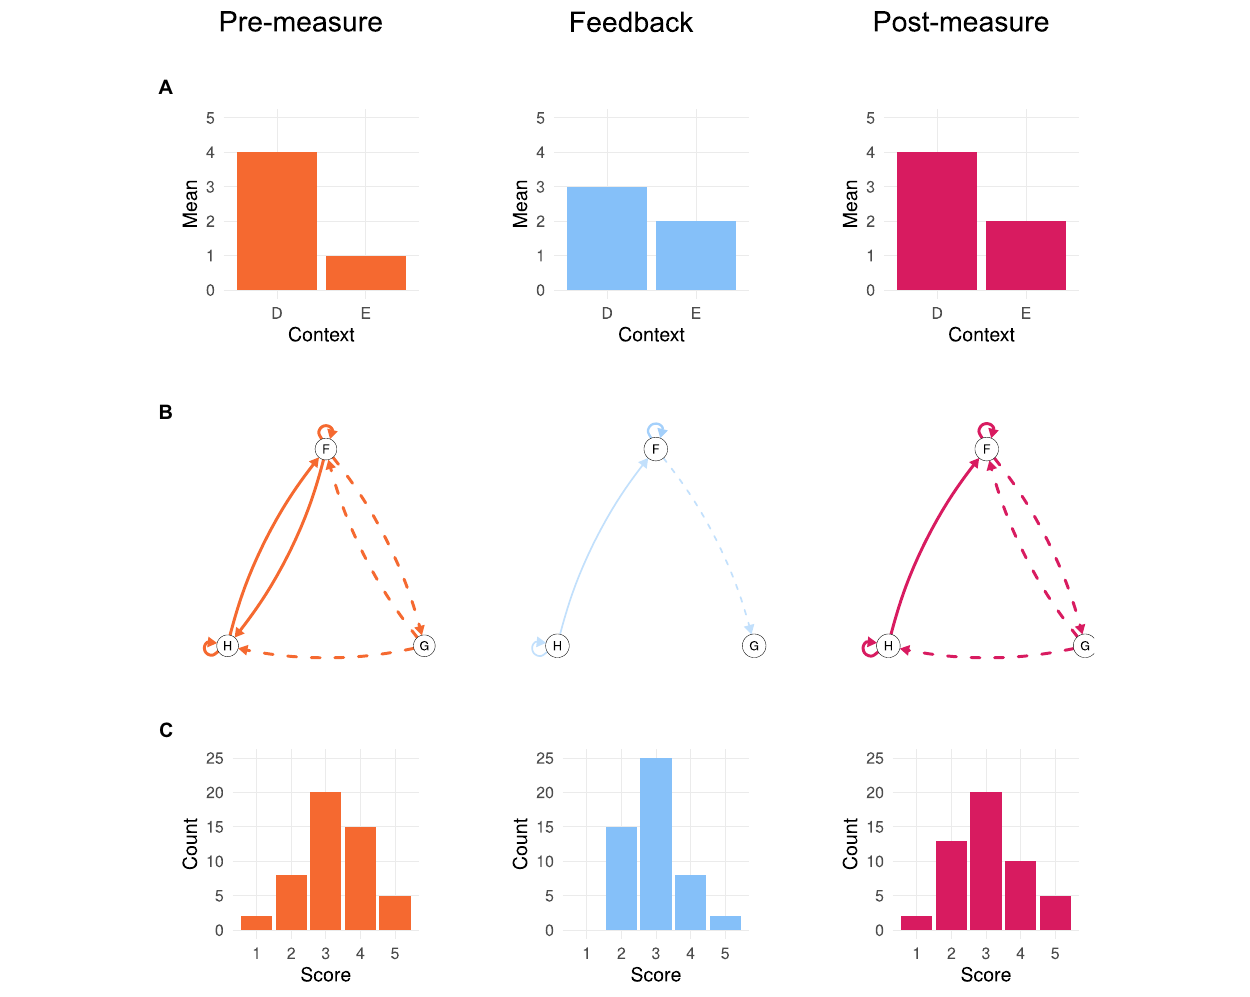
FIGURE 2 | Fictious examples of the proposed deductive feedback process of collecting a pre-measure (column 1), providing data-driven feedback (column 2), and collecting a post-measure (column 3). Row A shows hypothetical outcomes for a comparison of means of an experience ( y -axis) in different contexts D and E ( x -axis). Row B shows hypothetical outcomes of a comparison of predictive relations between experiences F , G , and H . Row C shows hypothetical outcomes for a comparison of distributions/histograms of scores ( x -axis) for an